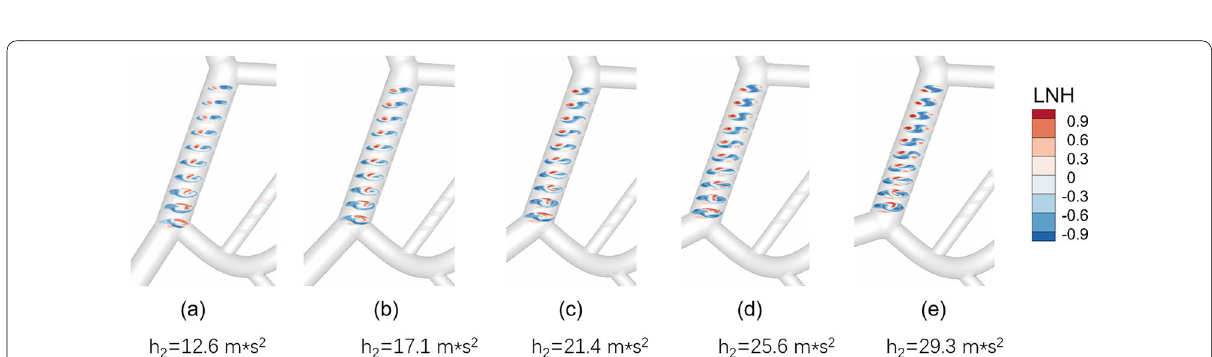
Fig. 5 The effect of the angulation of SMV and SV on helical flow in the PV; a , b , c , d , e represent the model with α respectively; h 2 , helical intensity; LNH, localized normalized